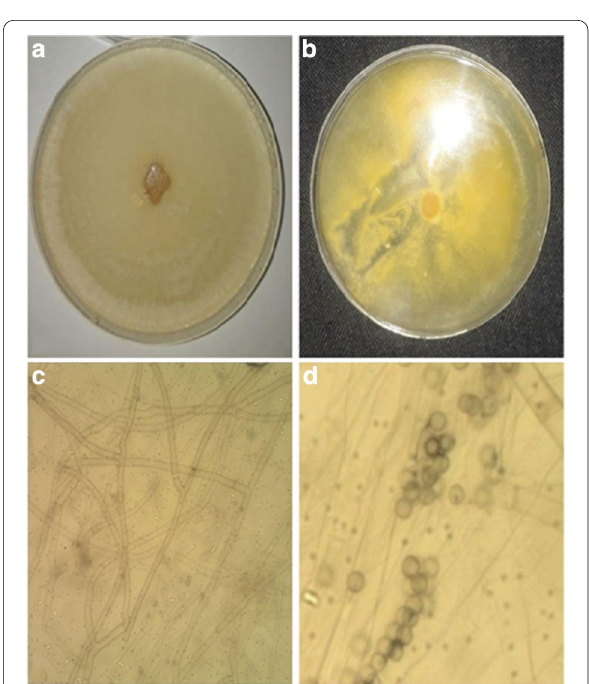
Fig. 5 a R. solani on PDA (top), b R. solani on PDA (bottom), c hypha of R. solani branched at almost right angle with a narrow restriction near the branch area with a transverse barrier. d Monilioid cells